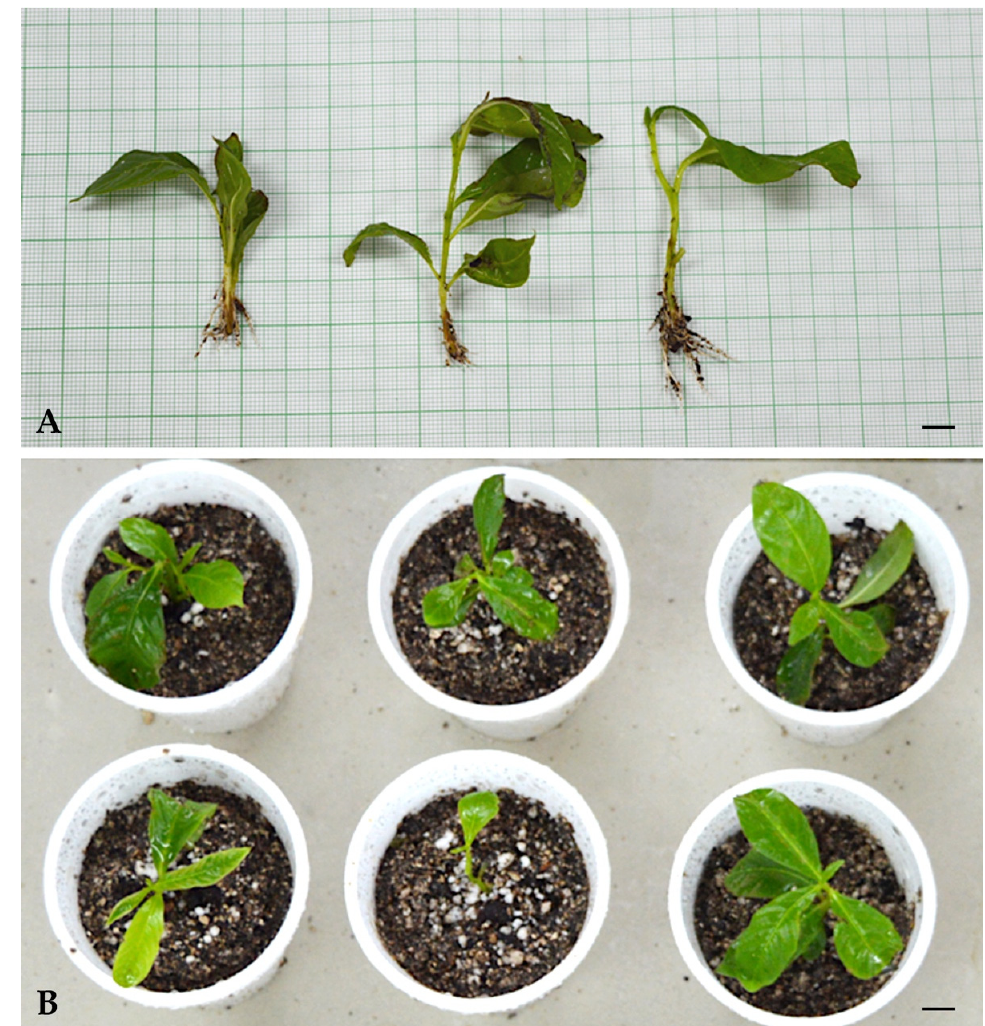
Figure 2. ( A ) Ex vitro rooted shoots of L. speciosa after pulse treatment with 200 µ M IBA (Bar = 0.6 cm); ( B ) 1-month-old, acclimatized plantlets of L. speciosa (Bar = 0.6 cm).